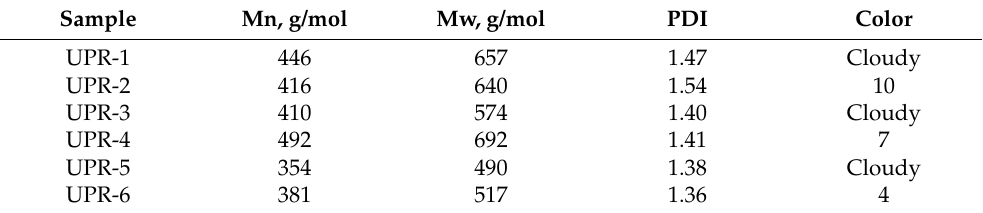
Table 5. Characteristics of UPR-1, UPR-2, UPR-3, UPR-4, UPR-5, and UPR-6 samples: number aver- age (Mn) and weight average (Mw) molecular weights, polydispersity index (PDI) and color.